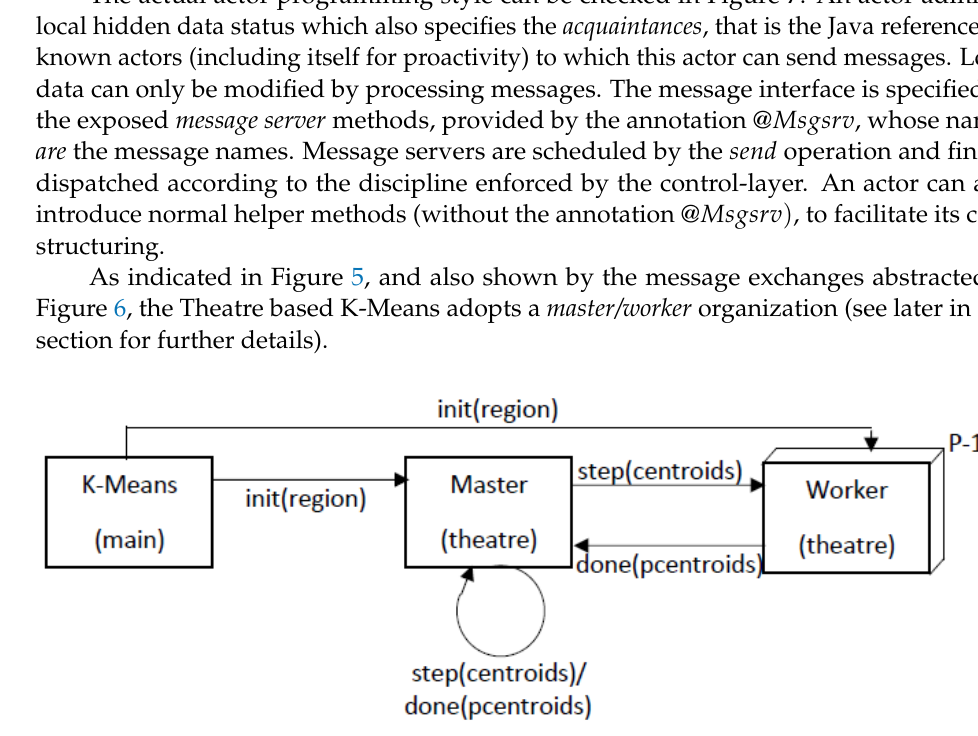
Figure 5. Supporting classes for Parallel K-Means based on Theatre.